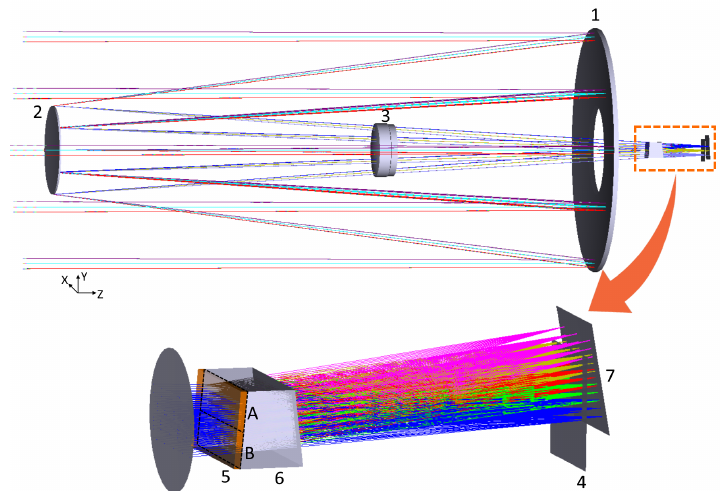
Figure 1. General view of the slitless spectrograph optics coupled with a Dall–Kirkham telescope: 1—primary mirror, 2—secondary mirror, 3—lens corrector, 4—focal plane position in the imaging mode, 5—composite holographic grating, split into zones with independently optimized parameters as A and B, 6—prism, 7—spectral image plane